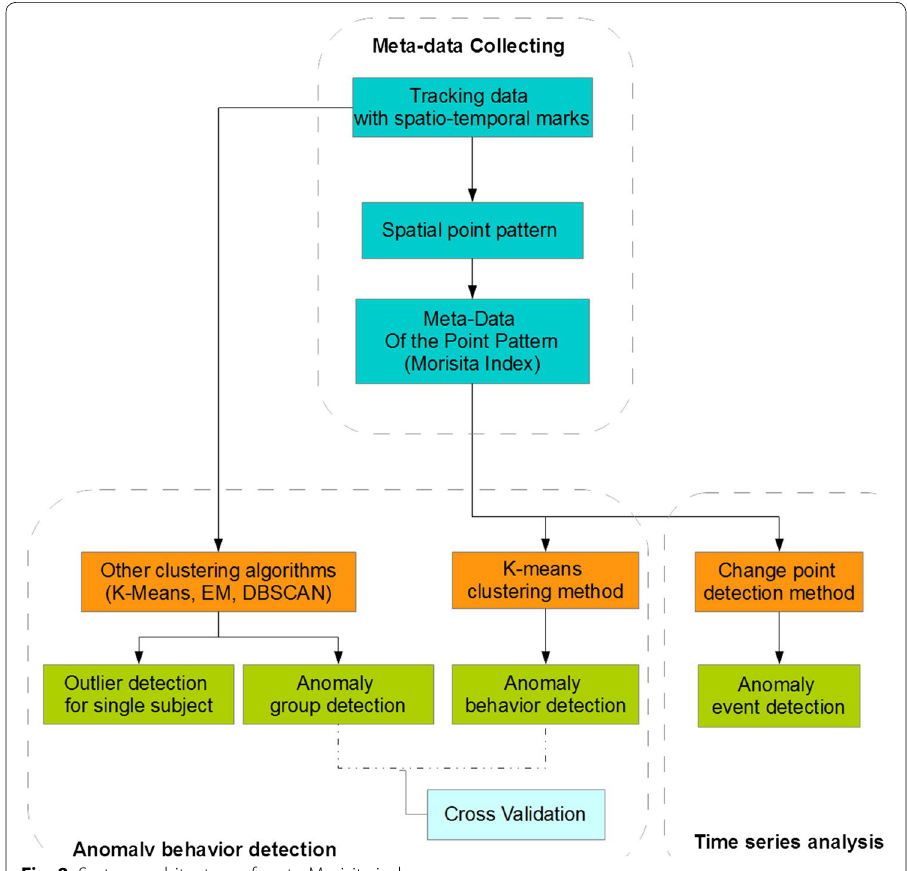
Fig. 8 System architecture of meta-Morisita